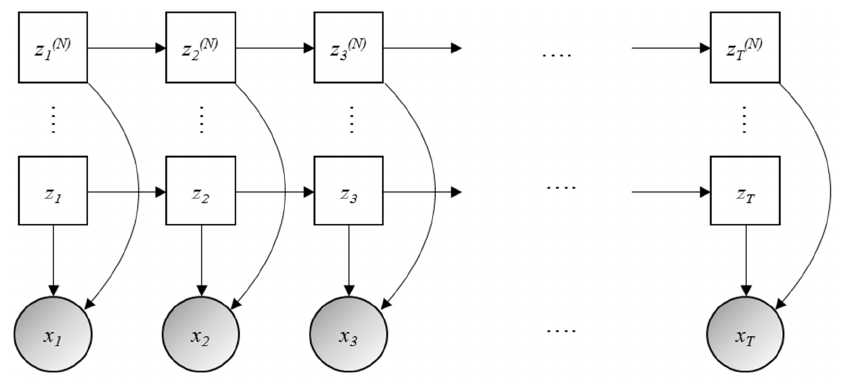
Figure 2. Factorial Hidden Markov Model [31].